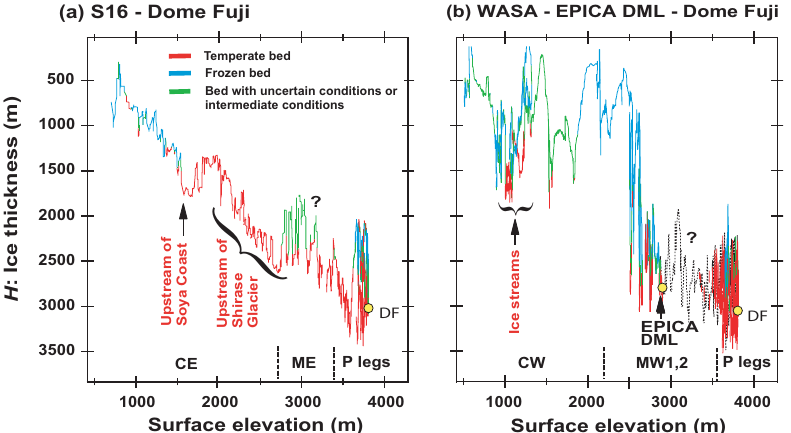
Fig. 11. Suggested bed conditions are plotted on graphs of ice thickness H (ordinate) versus surface elevation (abscissa). Panels (a) and (b) are for legs between S16 and the DF area and for legs from Wasa to the DF area, respectively. Frozen dry bed and temperate wet bed conditions are indicated as blue and red traces, respectively. Green traces indicate uncertain bed conditions. The thin black lines represent published data (Huybrechts et al., 2009). The locations of two ice coring sites, i.e. Dome Fuji and EPICA DML, are indicated by yellow